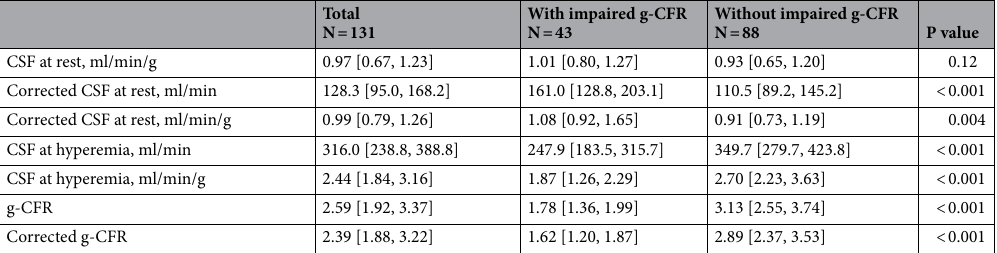
Table 1. Clinical characteristics of patients with and without impaired g-CFR (g-CSF < 2.0). ACE-I angiotensin-converting enzyme inhibitor, ARB angiotensin receptor blocker, cTnI cardiac troponin I, CT computed tomography, CSF coronary sinus flow, EDV end diastolic volume, EF , ejection fraction, eGFR estimated glomerular filtration rate, ESV end systolic volume, g-CFR global coronary flow reserve, HbA1c glycated hemoglobin, HDL-chol high density lipoprotein cholesterol, hs-CRP high sense c-reactive protein, HU Hounsfield units, LAD left anterior descending coronary artery, LCx left circumflex coronary artery, LDL-chol low density lipoprotein cholesterol, LVM left ventricular mass, LVMI left ventricular mass index, NT-proBNP N-terminal pro-B-type natriuretic peptide, PCATA pericoronary adipose tissue attenuation, RCA right coronary artery, TG triglyceride, TIMI thrombolysis in myocardial